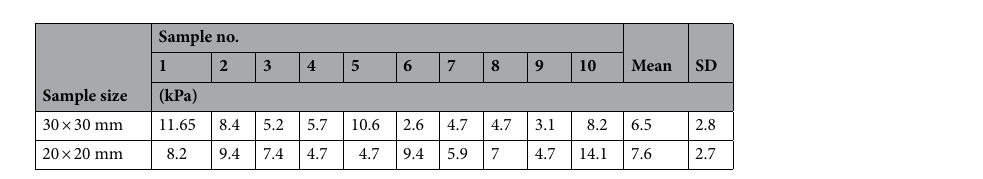
Table 1. Radial pressure at which the R 2 of line fitting reaches local maximum or 0.99.